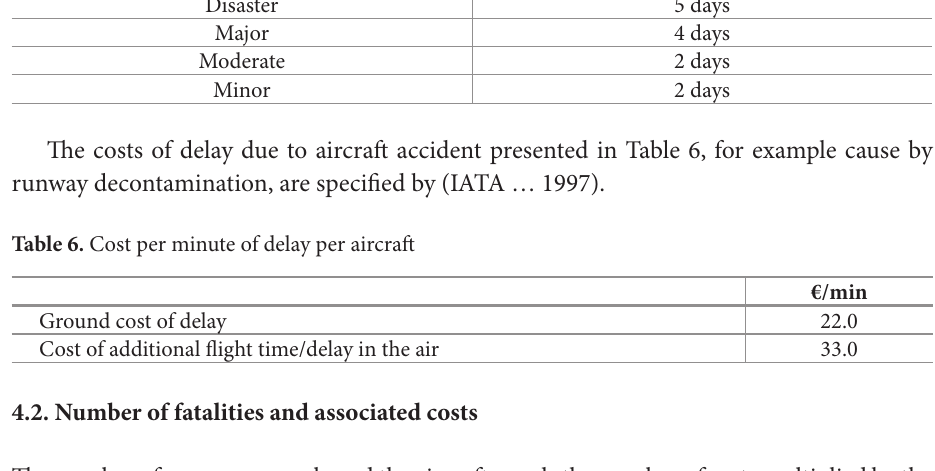
Table 5. Estimated airport closure relative to accident severity Catastrophic 5 days Disaster 5 days Major 4 days Moderate 2 days Minor 2 days